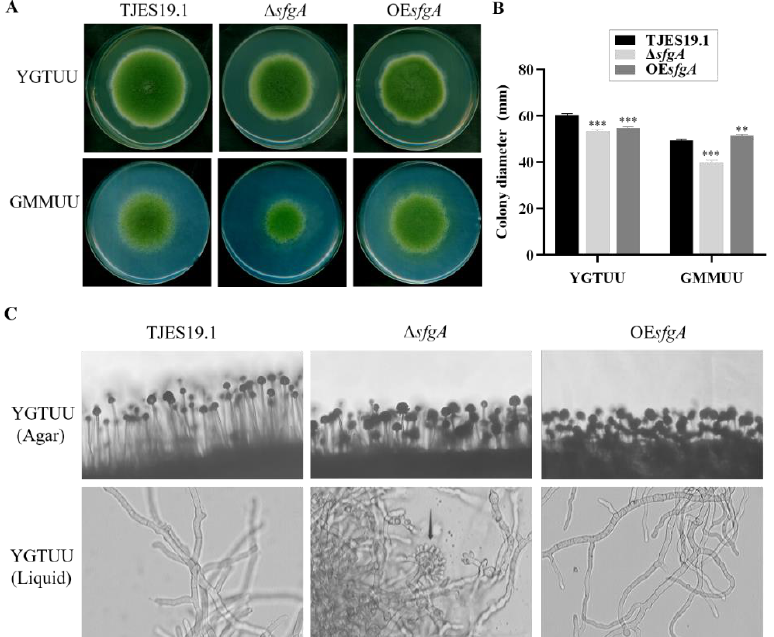
Figure 3. Fungal growth and conidiophore development of the ∆ sfgA mutant. ( A ) The colony phenotype of TJES19.1, ∆ sfgA, and OE sfgA strains point-inoculated on solid YGTUU and GMMUU media and propagated at 30 ◦ C for 5 days. ( B ) Quantitative analysis of colony diameter shown in ( A ). ** p ≤ 0.01; *** p ≤ 0.001. ( C ) Conidia formation of all strains were observed under a light microscope (magnification, 200 × ) at 48 h post-inoculation onto solid YGTUU and 14 h after inoculation into liquid YGTUU, respectively.